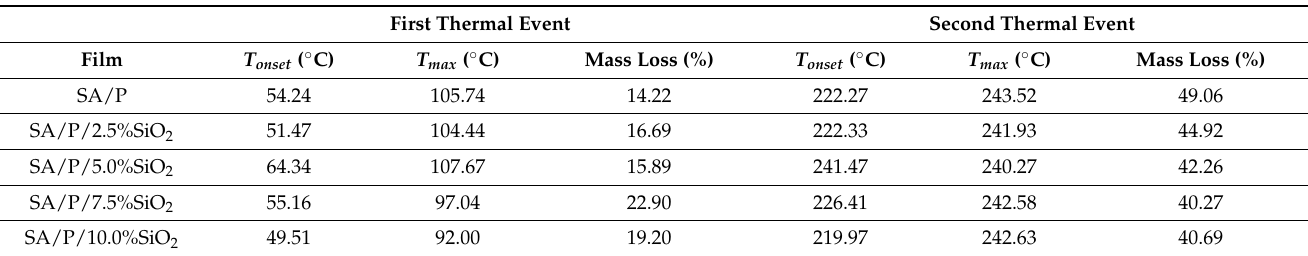
Table 1. Onset temperature ( T onset ), temperature of maximum degradation rate ( T max ) and mass loss of SA/P and SA/P/SiO 2 films.